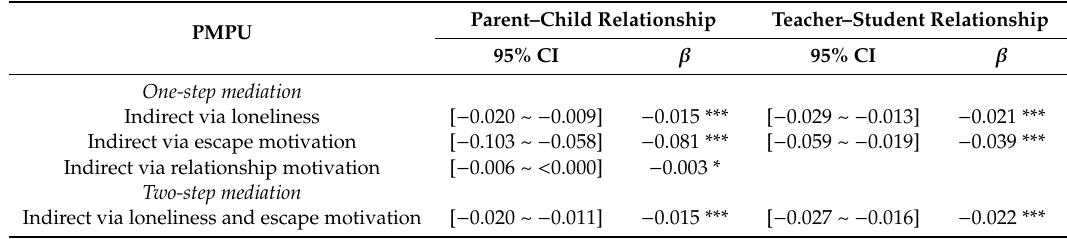
Table 2. Bias-corrected bootstrap test on mediating effects.